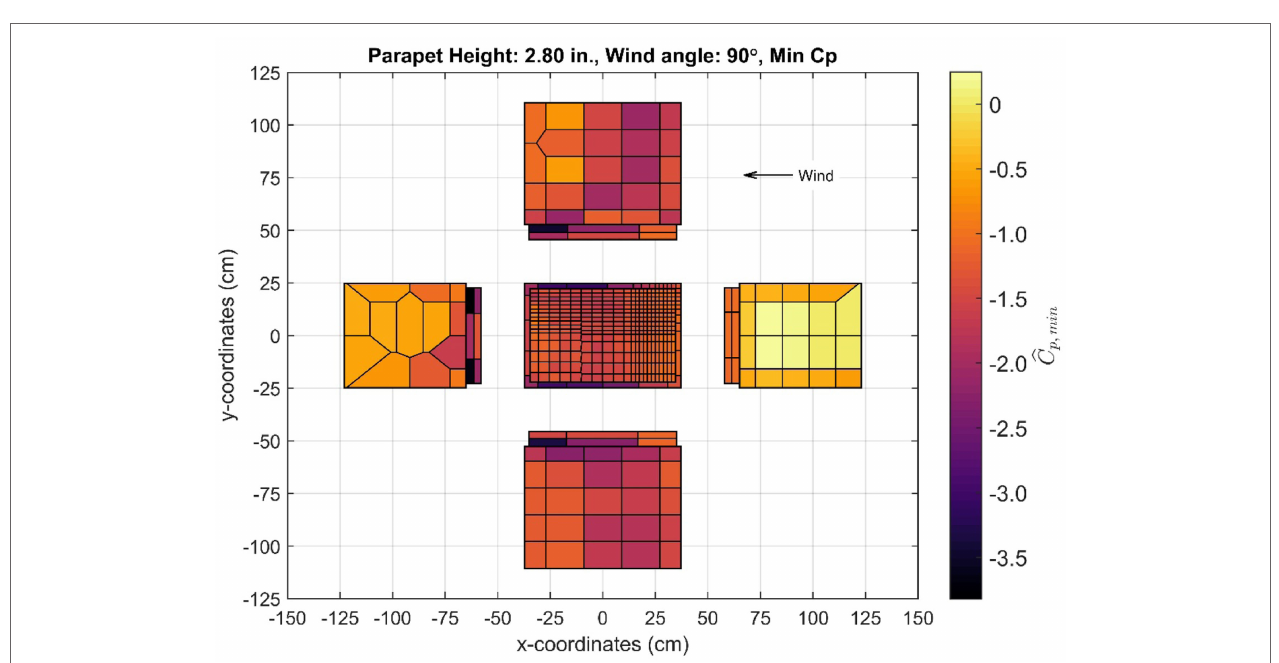
FIGURE 9 | ^ C p ; min for optimal parapet height, 90° wind angle